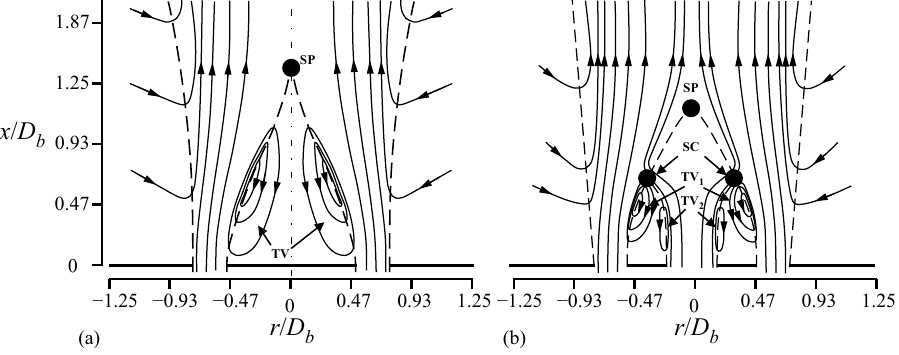
Figure 6. Streamline patterns observed in an aerodynamically shaped nozzle ( B r = 0.44, adapted from Chigier and Beér [35]). ( a ) Annular jet, r u = ∞ , and ( b ) coaxial jet, r u = 2.35. “SP”,“SC” and “TV” denote stagnation point, stagnation circle and toroidal vortices,